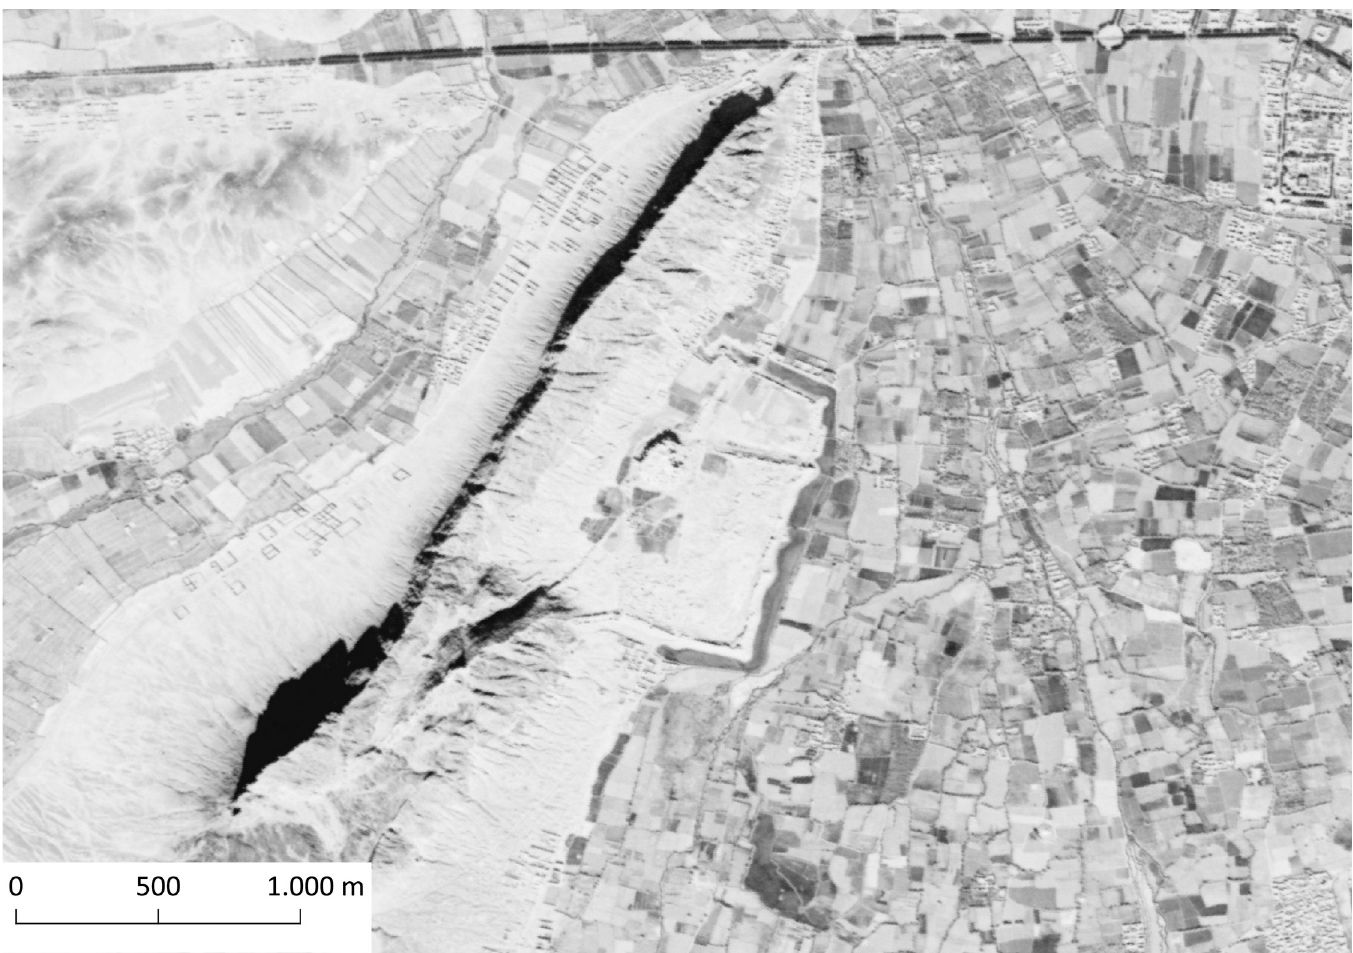
Fig 8. The old city of Kandahar. CORONA Satellite image courtesy of the U.S. Geological Survey (DS1108-2234DA032_a, 19.12.1969) (https://earthexplorer.usgs.gov).